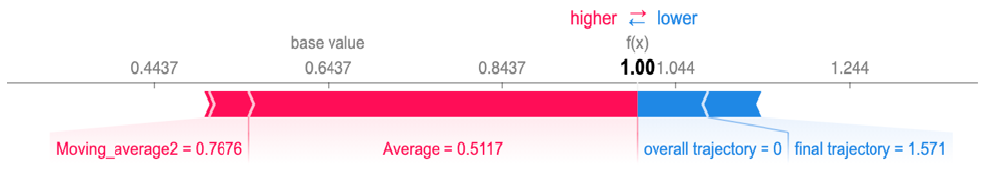
Figure 11. SHAP Force plot 1. Table 11. Input Values for SHAP Force Plot 2.